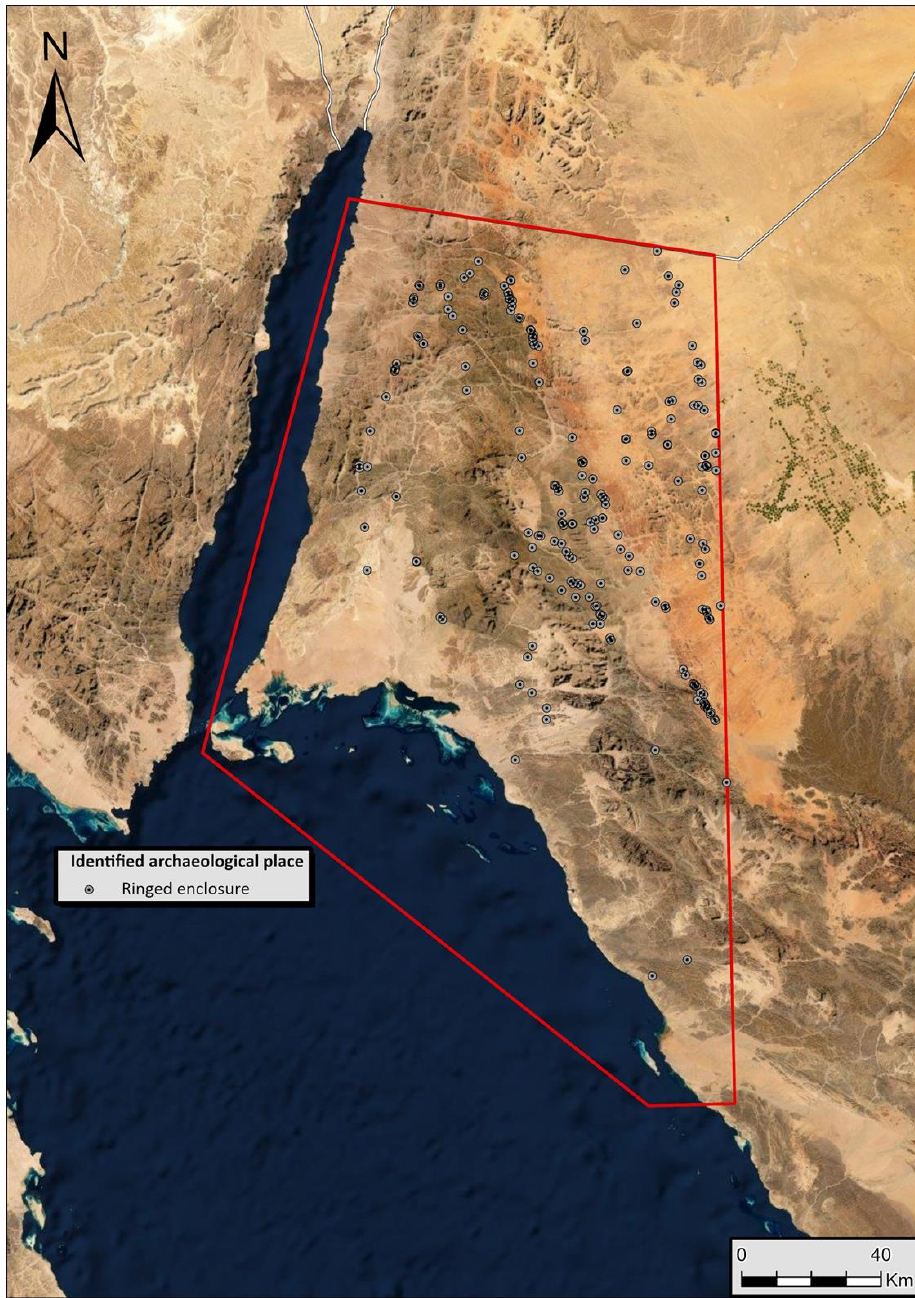
Figure 10. Distribution of ‘ringed enclosure’ structures .